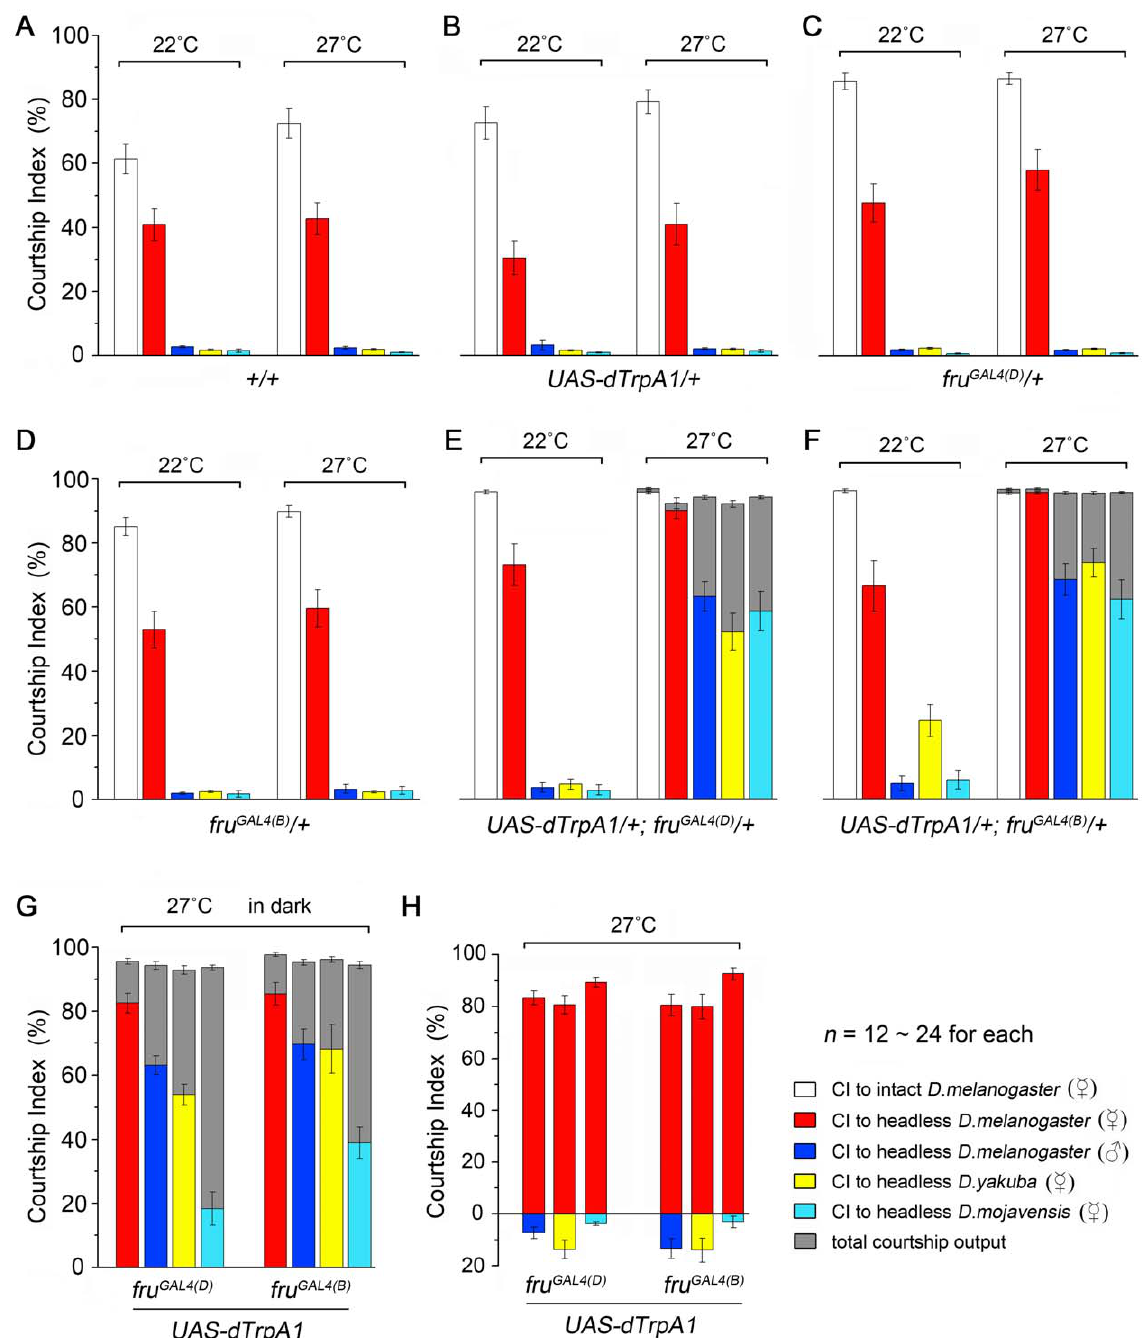
Figure 5. fru M neurons in courtship promotion and recognition. (A–F) Courtship indices of males of indicated genotypes paired with D. melanogaster females (white), headless D. melanogaster females (red), headless D. melanogaster males (blue), headless females of D. yakuba (yellow) or D. mojavensis (cyan). (A–D) Wild-type males (A) and males with UAS-dTrpA1 (B) or fru GAL4 alone (C–D, fru GAL4(D) and fru GAL4(B) respectively) directed strong courtship to intact and headless D. melanogaster females, but little to inappropriate targets at either 22 u C or 27 u C. (E–F) Activation of all fru M neurons induced consistently high level of courtship outputs (gray), with the highest levels being directed at D. melanogaster females, and less elevated levels directed at headless D. melanogaster males and headless females of D. yakuba and D. mojavensis . (G) Courtship indices of fru M - activated males paired with headless D. melanogaster females and males, and headless females of D. yakuba and D. mojavensis in the dark. (H) Courtship indices of fru M -activated males paired with two targets in a competitive assay. One target is always a headless D. melanogaster female, and the other is a headless D. melanogaster male or headless female of D. yakuba or D. mojavensis . For both fru GAL4 drivers, these males prefer to court conspecific females. n indicates number of males tested. Error bars indicate